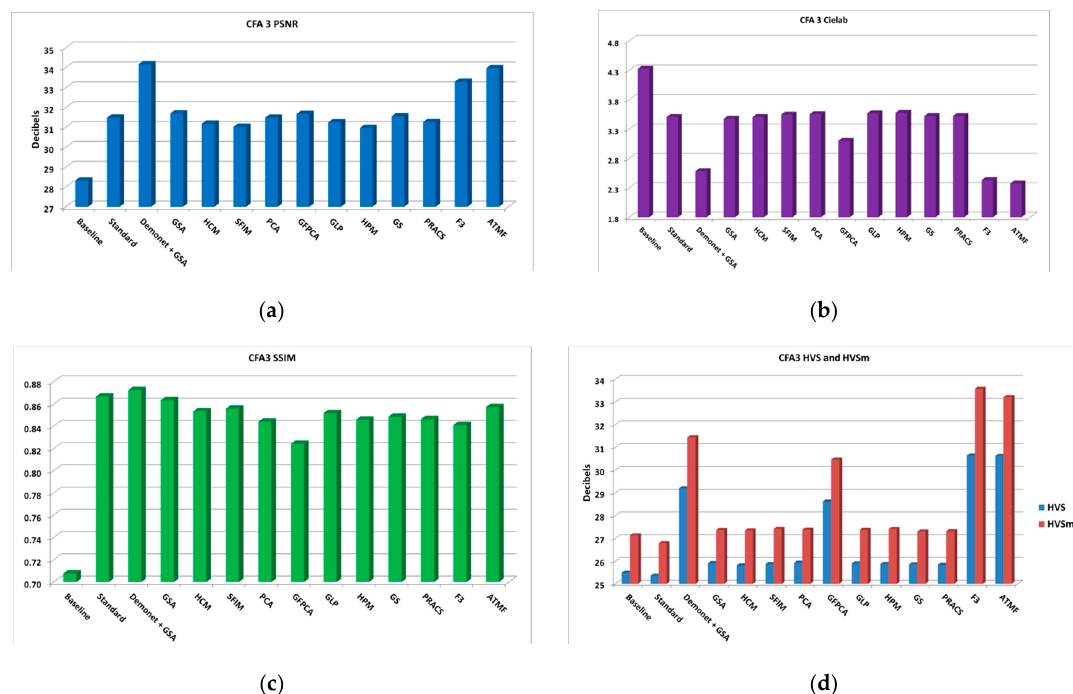
Figure 6. Averaged performance metrics for all the clean images. ( a ) PNSR; ( b ) CIELAB; ( c ) SSIM; ( d ) HVS and HVSm. Sensors 2020 , 20 , x